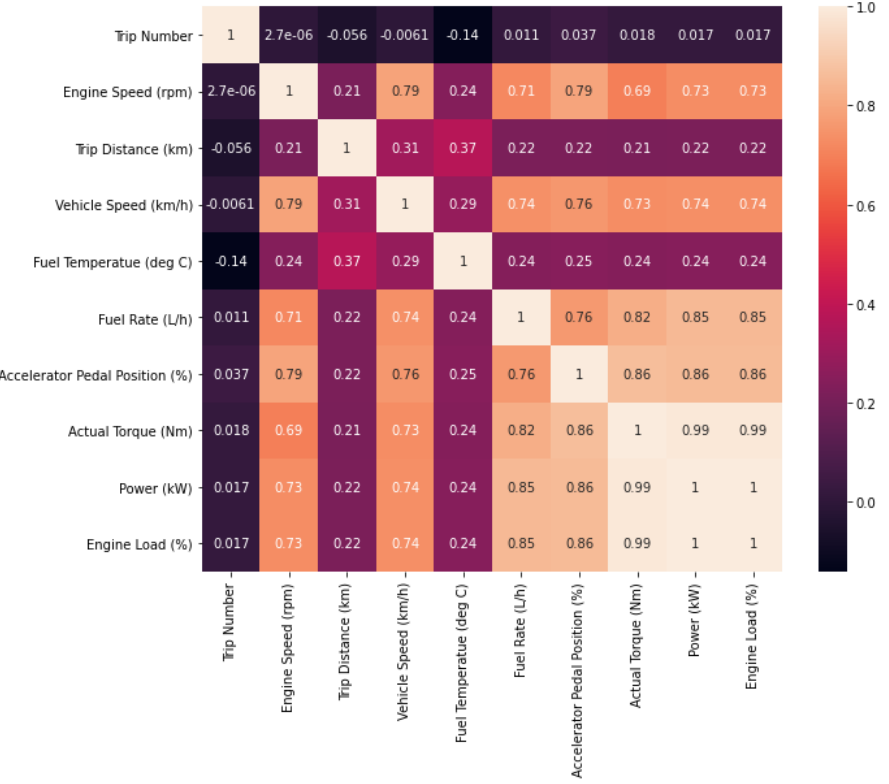
Figure 2. The correlation matrix shows the correlation coefficient between variables. The last four rows and columns of the correlation matrix indicate that the independent features accelerator pedal position (%), actual torque (ft − lb), power (bhp), and engine load (%) are highly correlated to each other with a correlation coefficient of 0.85 and higher. Hence, to prevent overfitting of the model, only engine load (%) of the four parameters was used in modeling. Feature dimension can further be reduced by identifying the highly correlated features with the target variable fuel rate (L/s). The recursive feature elimination (RFE) method was used to identify and plot the feature importance scores. RFE determines the features based on the desired number by searching the subset of features starting with all features and recursively removing features. Feature importance of the remaining features, including engine load (%), accelerator pedal position (%), fuel temperature (deg C), vehicle speed (km/h), trip distance (km), and engine speed (rpm) concerning fuel rate (L/s), was determined with the RFE technique, and the top three features with the highest scores were selected for modeling. Based on the feature analysis, three independent features, namely engine load (%), vehicle speed (km/h), and engine speed (rpm), with high importance were selected for modeling the dependent feature fuel rate (L/s) and to identify patterns in fuel